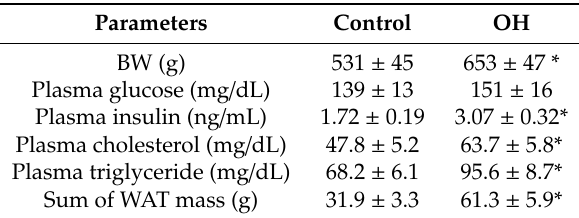
Table 1. Metabolic parameters and anatomic data in control and obesity related hypertensive (OH) rats after 12 weeks of a high-fat